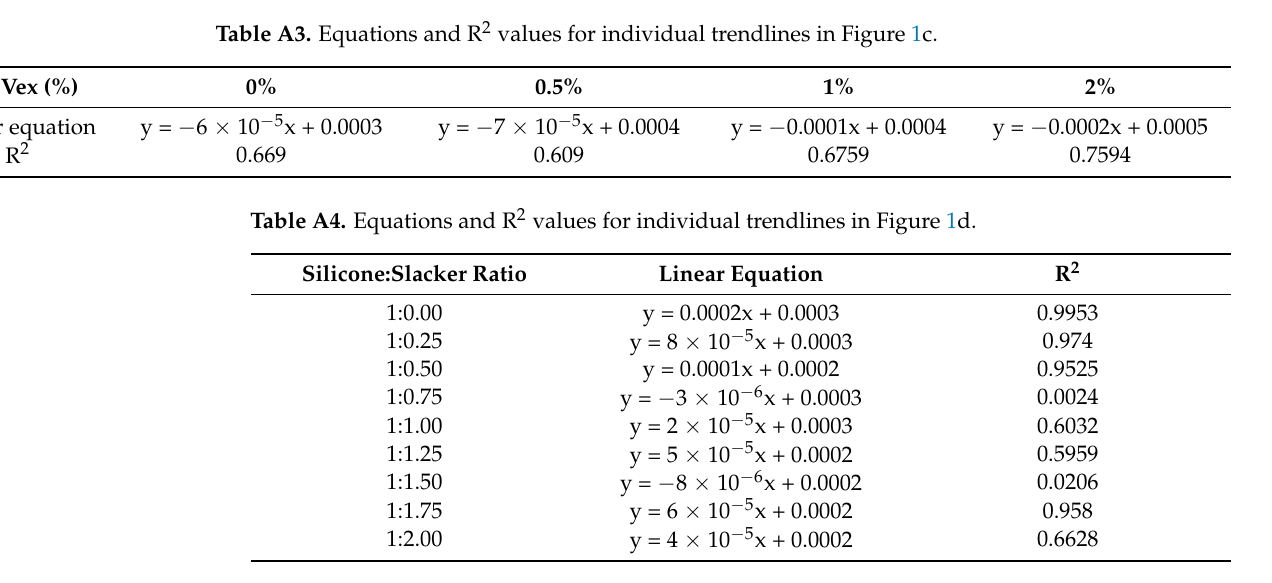
Table A5. Significant difference in conductivity between various Thi-vex concentrated groups. A significant difference was indicated with O and an insignificant difference was indicated with x.